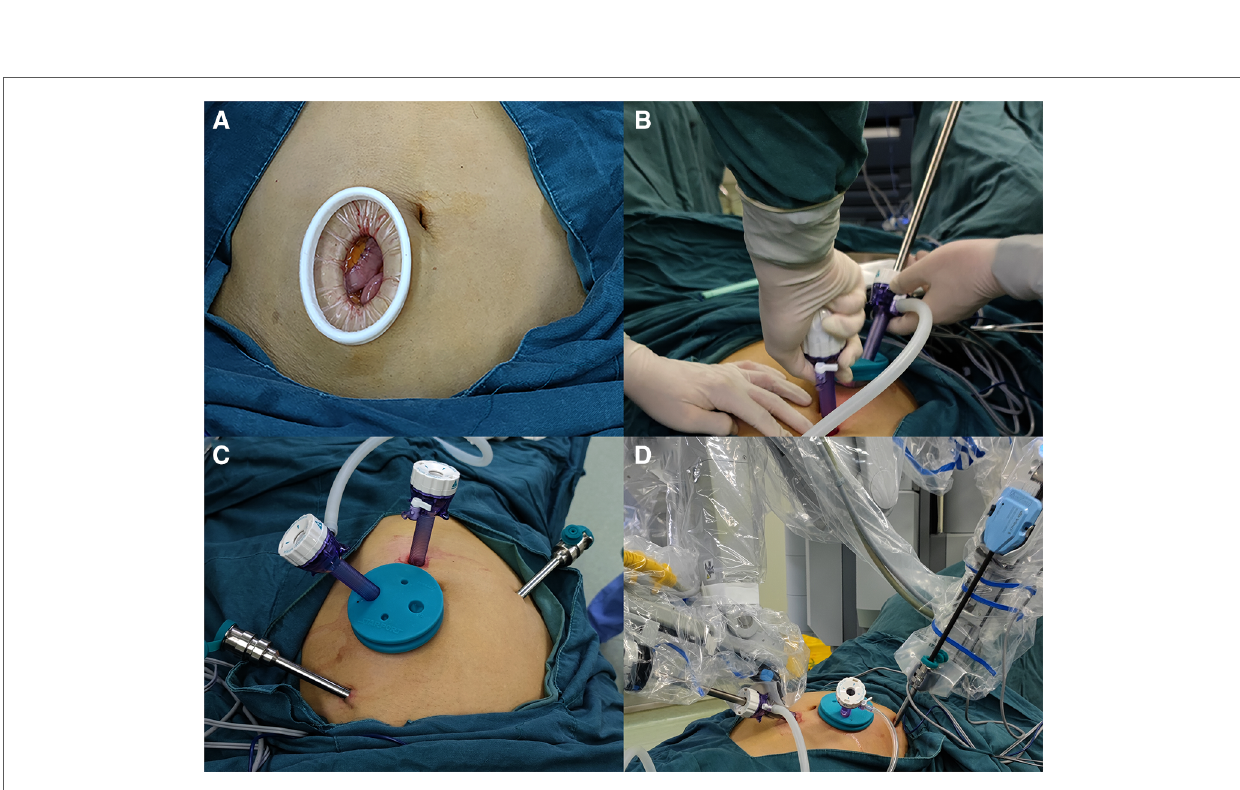
FIGURE 2 ( A ) The advance incision with an alexis wound retractor. ( B ) Inserting the camera port under direct vision through the advance incision. ( C ) The photograph of the advance incision and the port placement in the advance incision group. ( D ) The photograph of docked robot in the advance incision